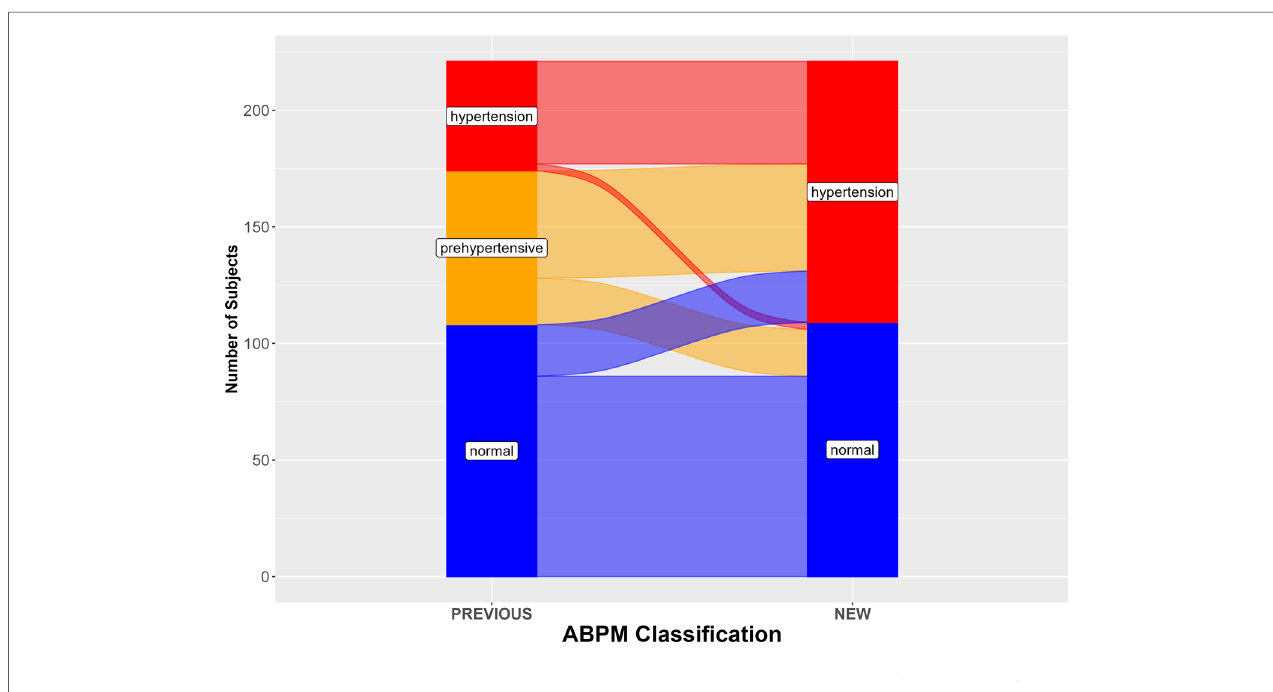
FIGURE 1 ABPM diagnoses according to new (2022) and previous guidelines, in 221 subjects. The alluvial plot is based on the values reported in Table 2 .